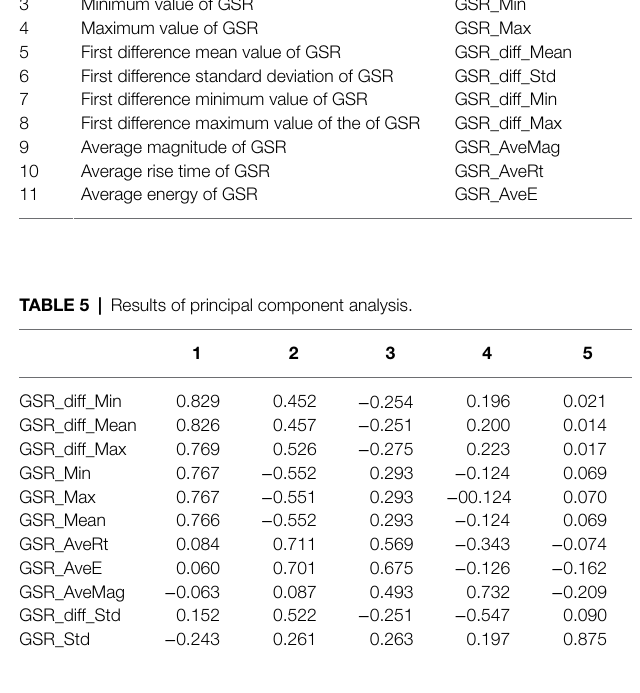
Table 7 . Workers in the positive emotional state had the shortest